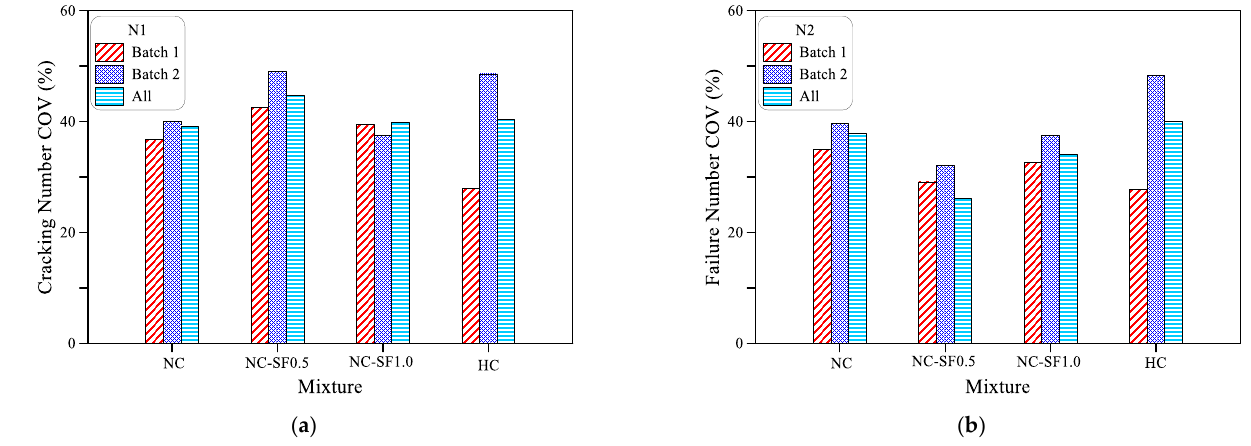
Figure 7. Coefficients of variation in the impact numbers for ( a ) N1 and ( b ) N2.